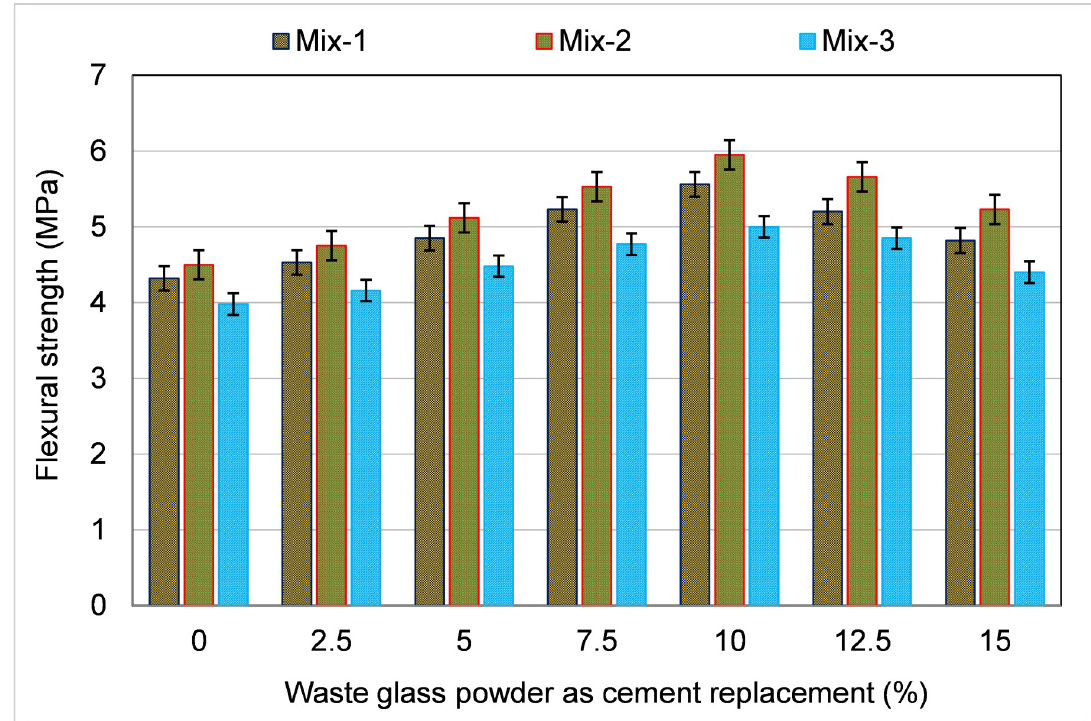
Fig 7. Influence of waste glass powder as cement substitute on FS of specimens.